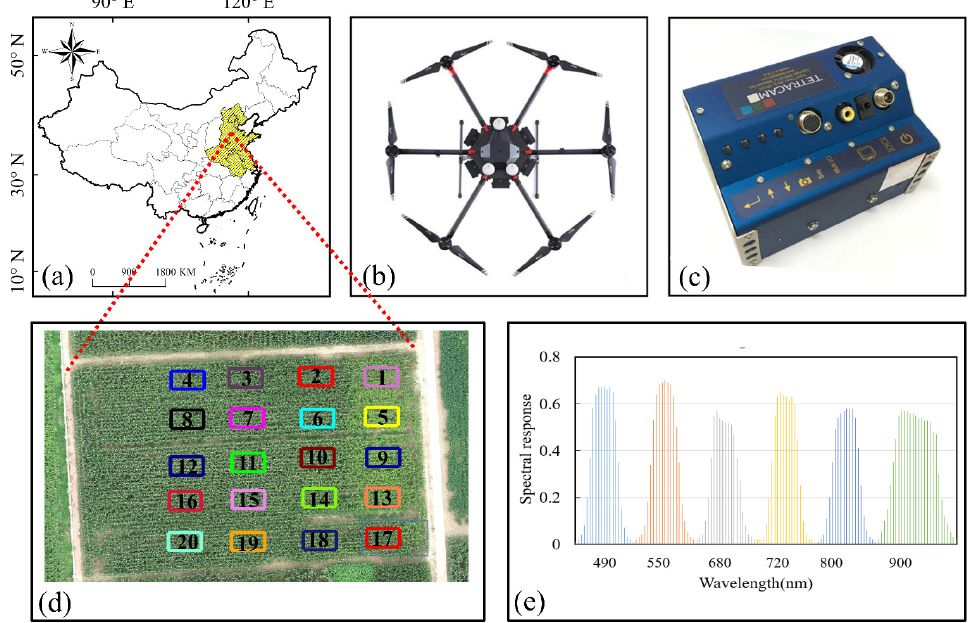
Figure 1. The brief description of the geo-location of the Nanpi Eco-Agricultural Experimental Station (NEES). ( a ) represented the geographic location of NEES, ( b ) represented the DJI M600 Pro, ( c ) represented the Mini MCA 6 Camera (MMC), ( d ) represented the detailed deployment and region of interest (ROI) of 20 plots, and ( e ) indicated the spectral response of each band of MMC. The DJI M600 Pro UAV platform (https://www.dji.com/cn/matrice600-pro, Shen-